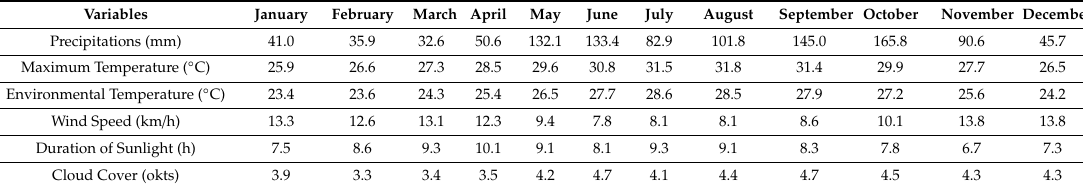
Table 2. Monthly mean values in Jardines del Rey (meteorological station of Cayo Coco,